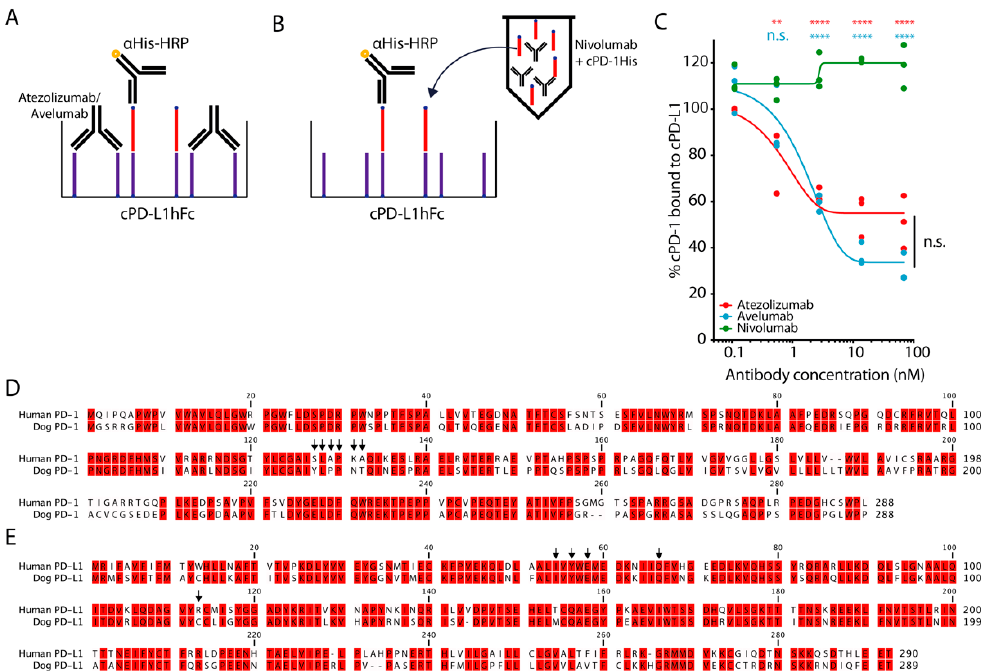
Figure 2. Blockade of interaction of PD-1 and PD-L1. ( A , B ) Outline of experimental setup blocking cPD-1/cPD-L1 binding by atezolizumab, avelumab and nivolumab. 20 μ g/mL cPD-L1Fc (purple) was coated on a microwell plate and binding of 20 μ g/mL cPD-1His (red) was detected on the plate, either ( A ) after blockade of cPD-L1 on the plate with atezolizumab and avelumab, or ( B ) preincubated with various concentrations of nivolumab [17] ( C ) Percentage of cPD-1 binding to cPD-L1 after blockade with indicated ICIs. Triplicates with fitted curve (log agonist versus response). Representative plot from three independent experiments (Mean, SEM, Two-way ANOVA with Bonferroni post-test comparing all pairs of columns, ** p < 0.01, **** p < 0.0001). ( D , E ) Sequence analysis of canine and human ( D ) PD-1 and ( E ) PD-L1. Black arrows depict crucial residues for binding each other and for blockade of the interaction by ICIs [29] .